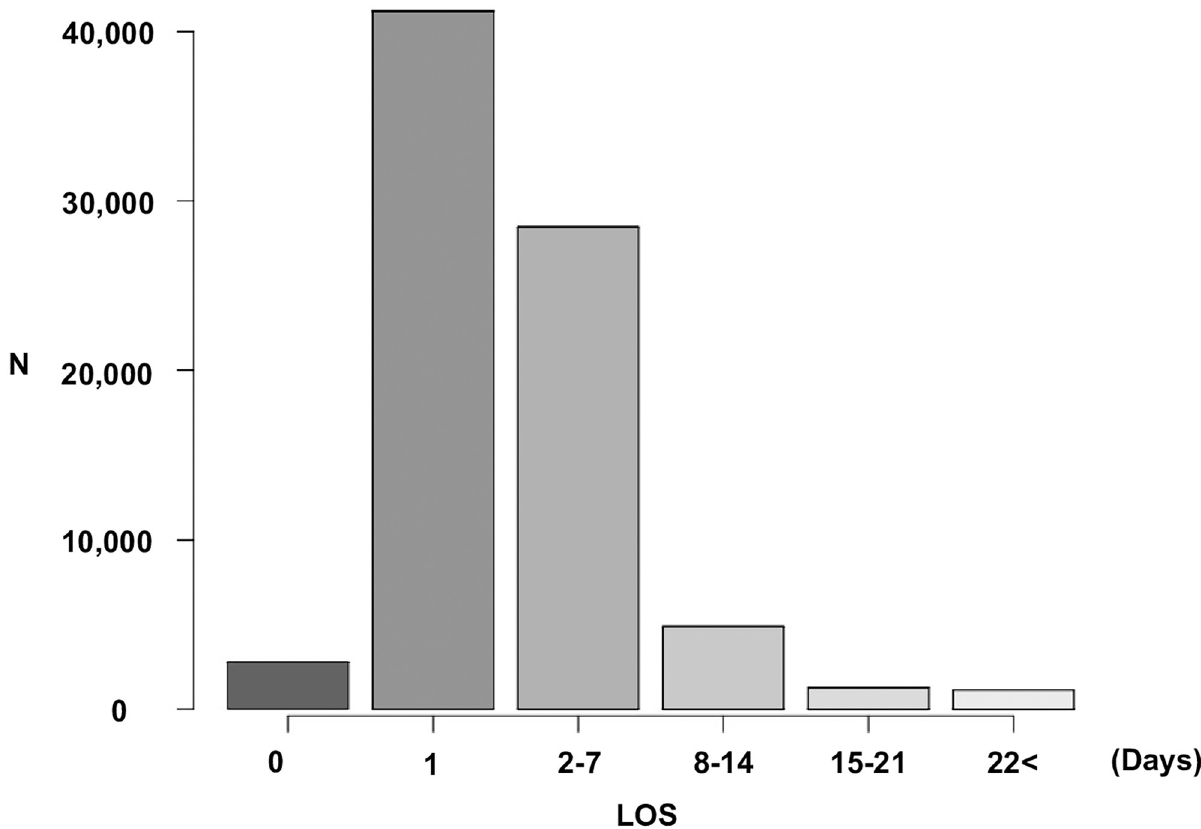
Fig 2. Distribution of patients stratified by length of stay in